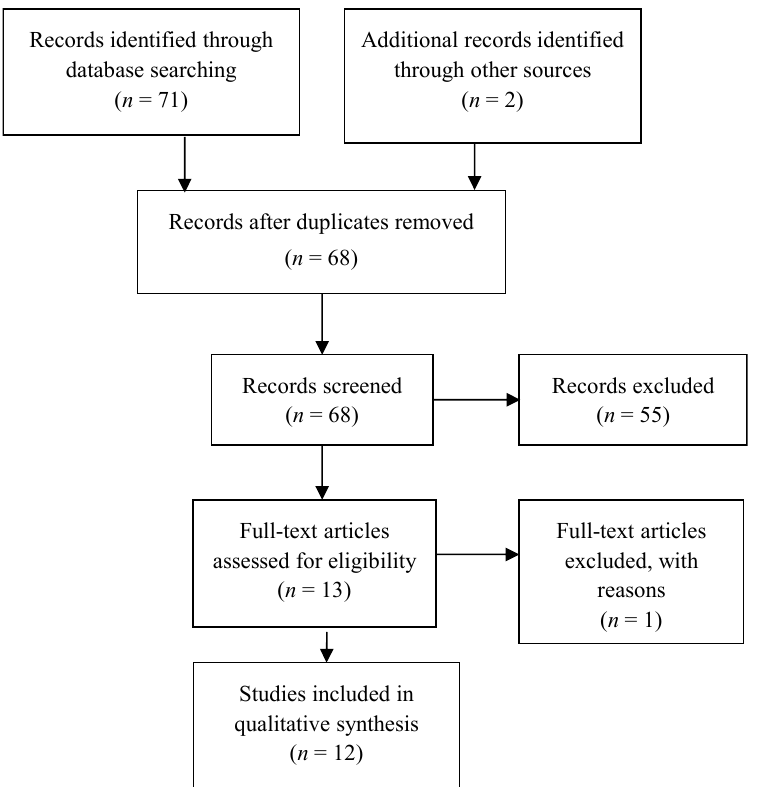
Figure 1. Preferred Reporting Items for Systematic Reviews and Meta-Analyses (PRISMA) Flow Diagram.